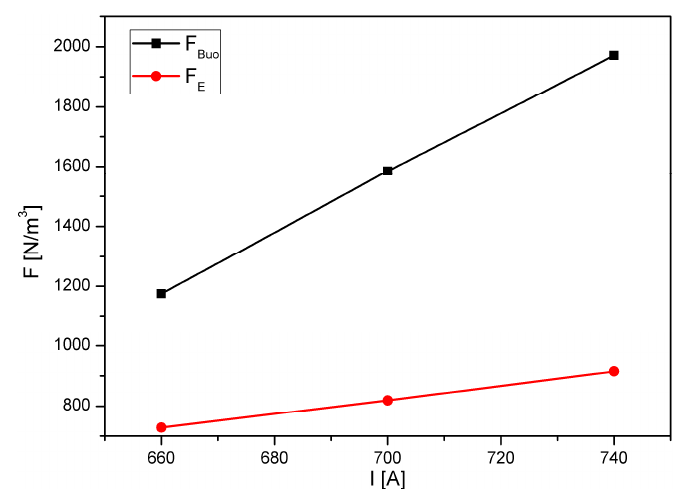
Figure 4. Comparison of the maximum values of the thermal buoyancy and electromagnetic force, the black line is the thermal buoyancy, and the red line represents the electromagnetic force.